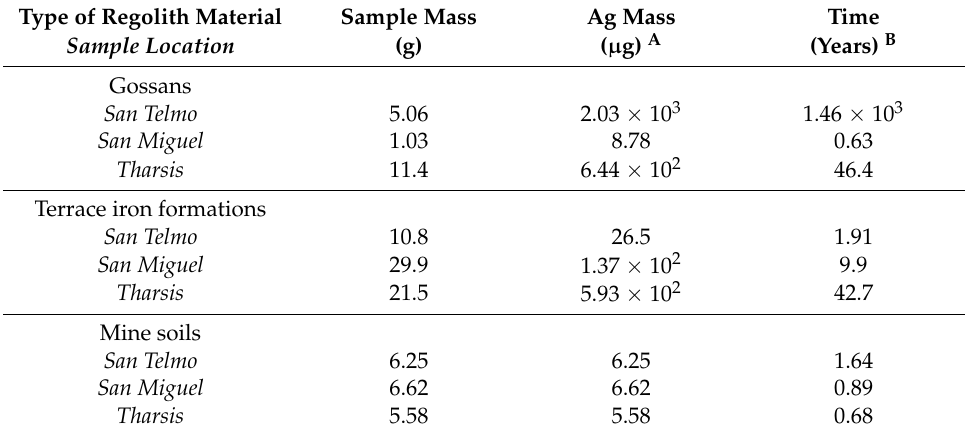
Table 3. Calculations for estimating the length of time for Ag dissolution and re-precipitation, i.e., cycling, to occur within gossans, terrace iron formations and mine soils based on Ag concentrations determined by